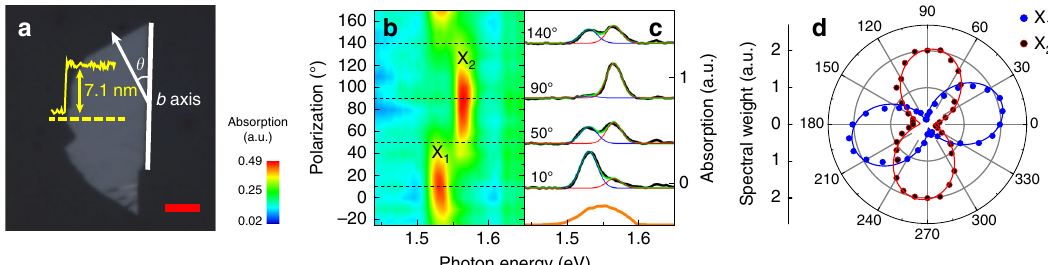
Fig. 2 Anisotropic excitons in ReS 2 . a Optical image of the few-layer ReS 2 . White line along the edge of the fl ake represents the b axis. θ is the angle optical polarization (arrow). Yellow graph shows the AFM pro fi le along the dashed line. The scale bar is 20 μ m. b – d Polarization-dependent absorption of the ReS 2 ( b ) and several linecuts at four different θ (black lines in ( c )). The blue (red) lines are Voigt fi ts of the X 1 (X 2 ). Corresponding Voigt spectral weights (dots) and fi ts (lines, Supplementary Note 1) are shown in d . Orange line in c is the pump pro